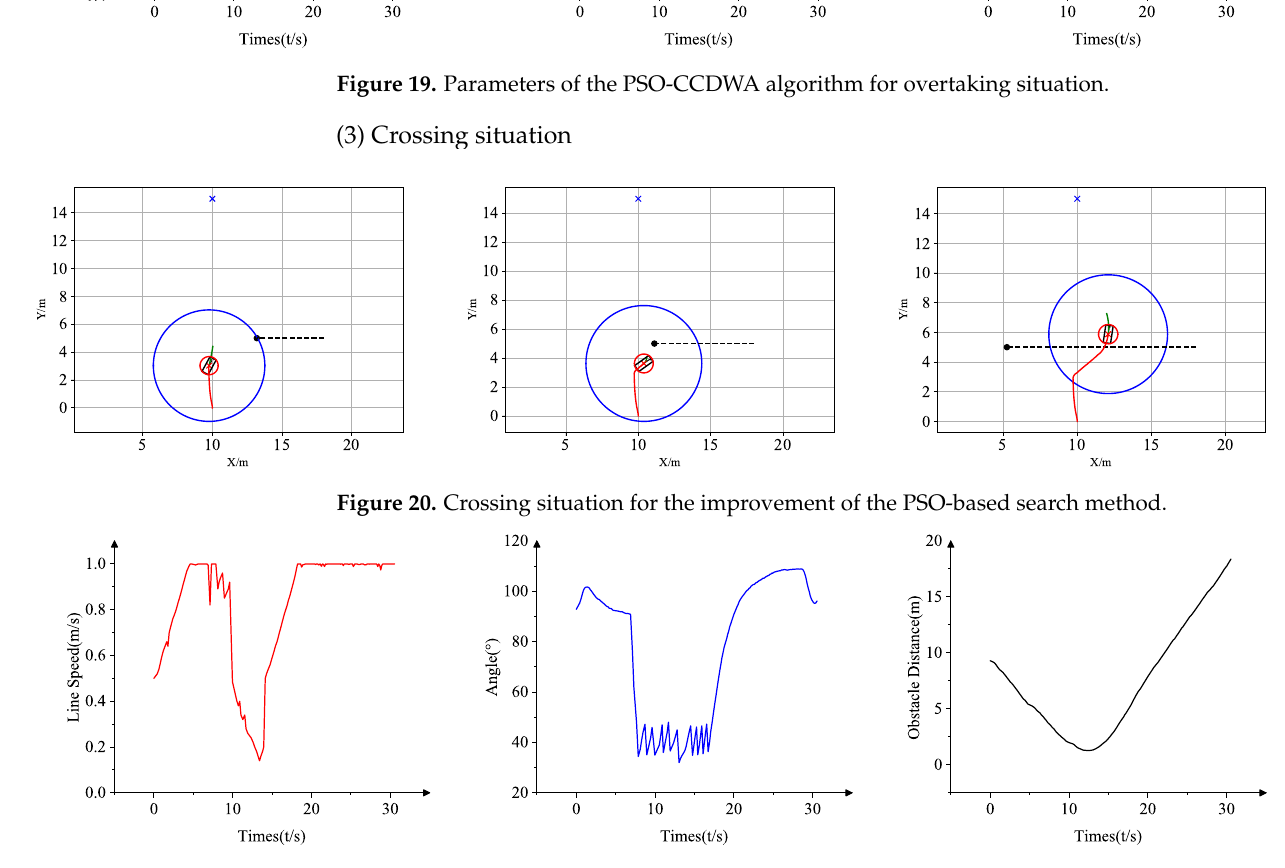
Figure 21. Parameters of the PSO-CCDWA algorithm for crossing